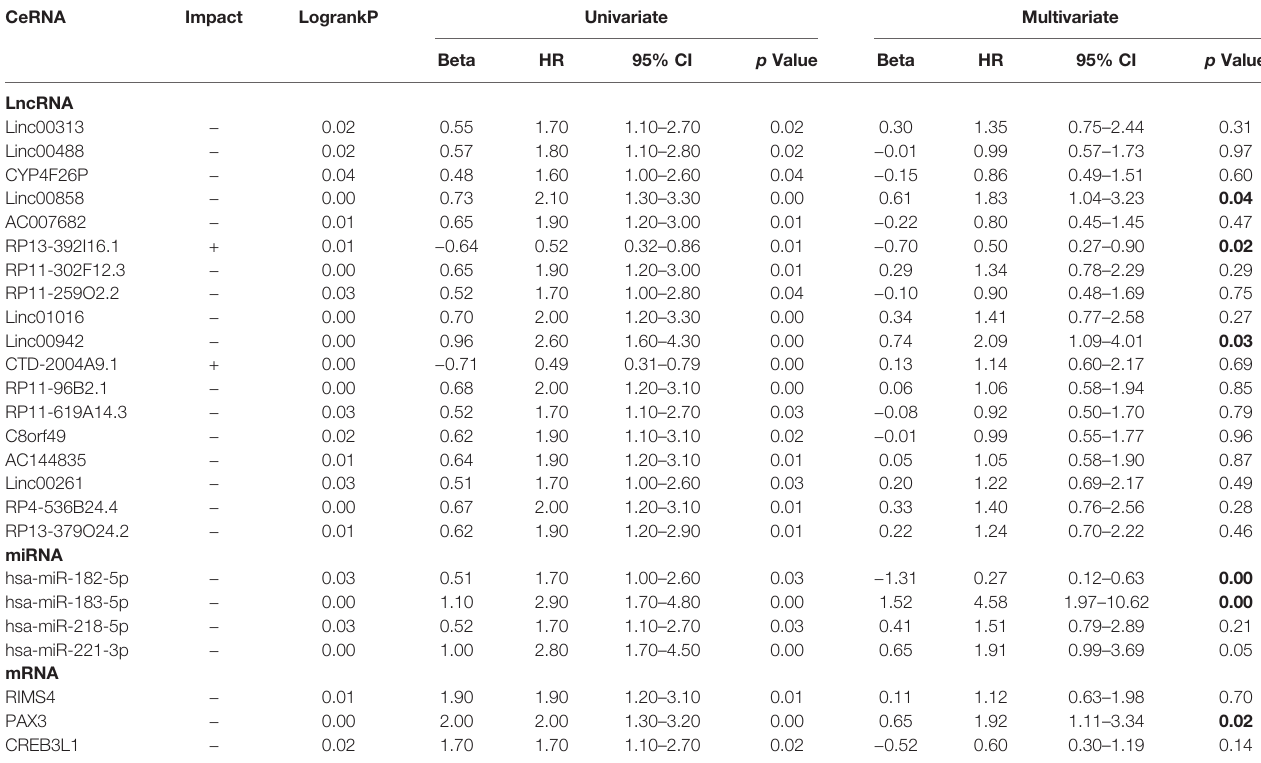
TABLE 1 | Univariate and multivariate cox regression analysis of survival-related lncRNAs, miRNAs, and